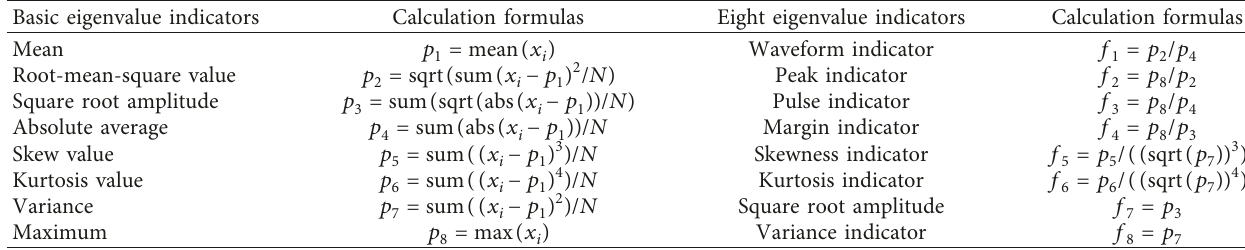
Table 1: Calculation formulas of eigenvalue indicators.